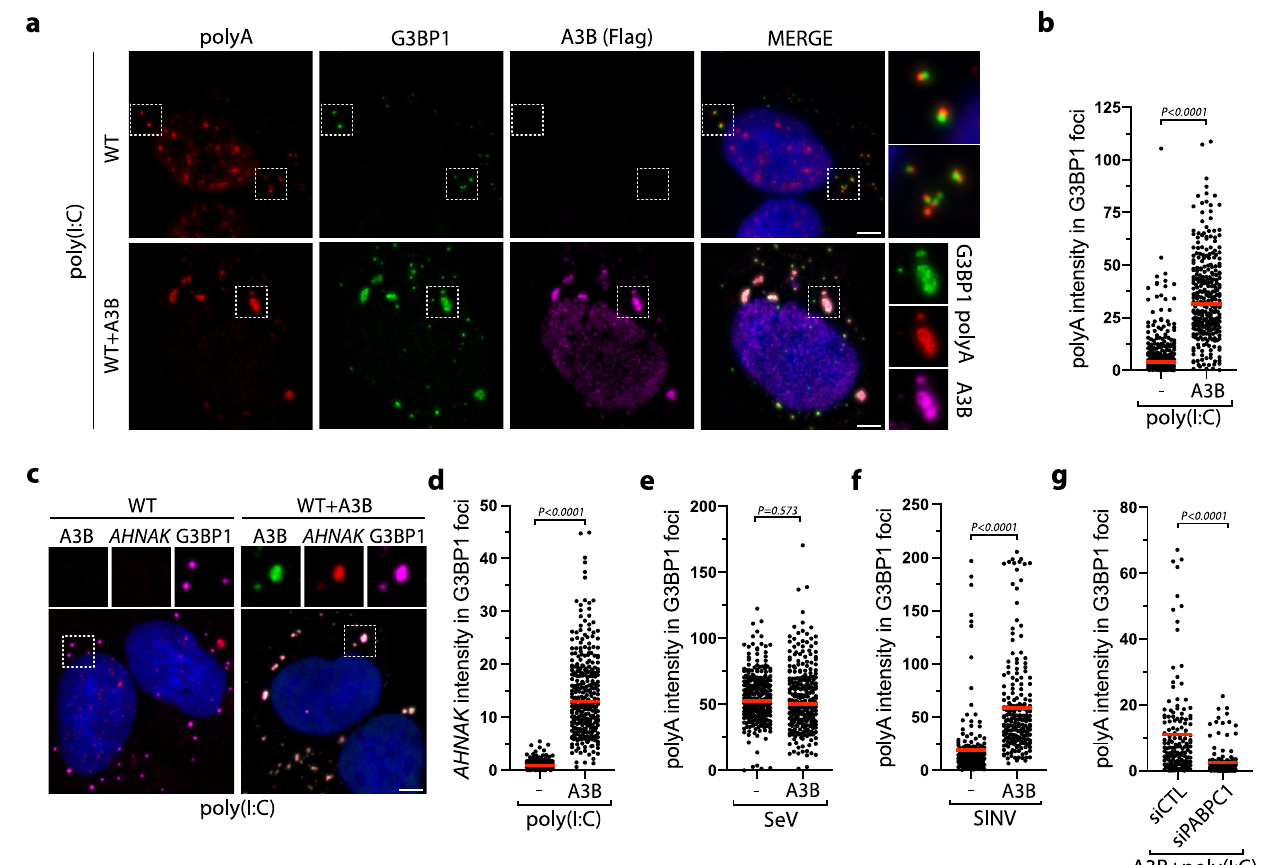
Fig. 8 | APOBEC3B preventsthedegradationofstress granule-associatedRNAs by RNase L. a Poly(A), G3BP1, and A3B localization were monitored by sequential IF-FISH (Fluorescence in situ hybridization) in U2OS-A3B- fl ag cells ± DOX after transfection with poly(I:C) (200ng/mL, 16h). Scale bar: 5 μ m. b Quanti fi cation of poly(A) intensity in G3BP1 foci (arbitrary units) from the experiment described in ( a ). Red lines indicate the mean (Number of G3BP1 foci, n =300). P -values were calculated with a two-tailed Welch t -test. c A3B, AHNAK mRNA, G3BP1 localization were monitored by sequential IF-FISH in U2OS-A3B- fl ag cells ± DOX after trans- fectionwithpoly(I:C)(200ng/mL,16h).Scalebar:5 μ m. d Quanti fi cationof AHNAK mRNA intensity (arbitrary units) in G3BP1 foci after the treatment described in ( c ).